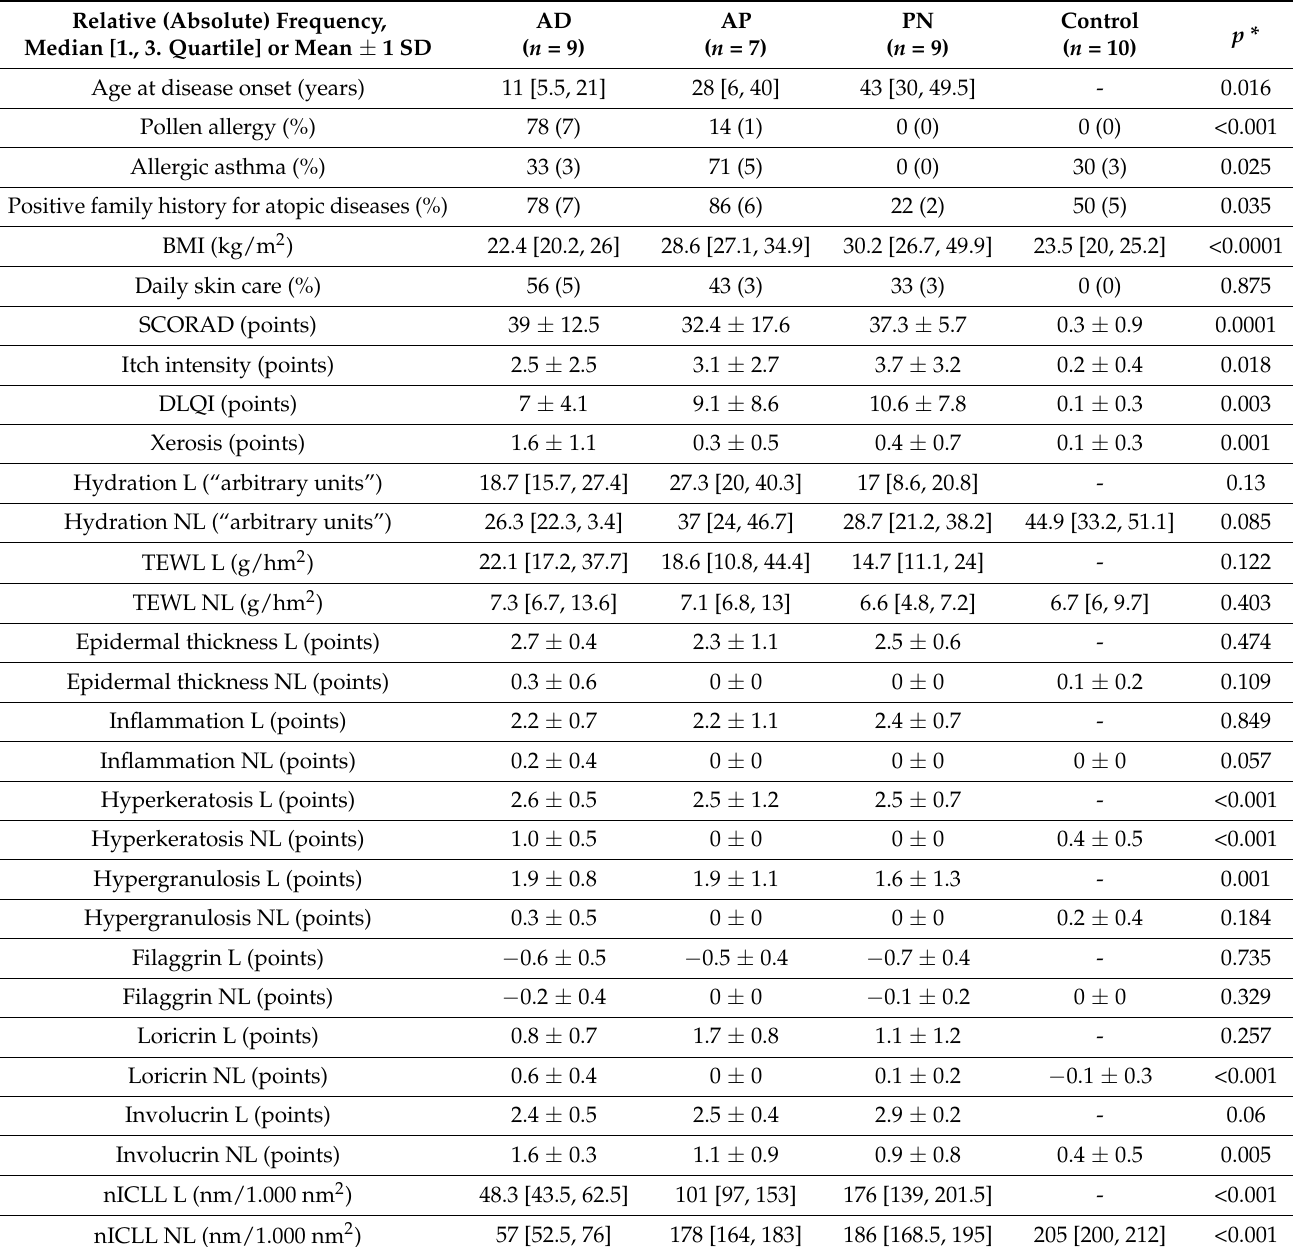
Table 1. Clinical characteristics and epidermal barrier parameters of the four study